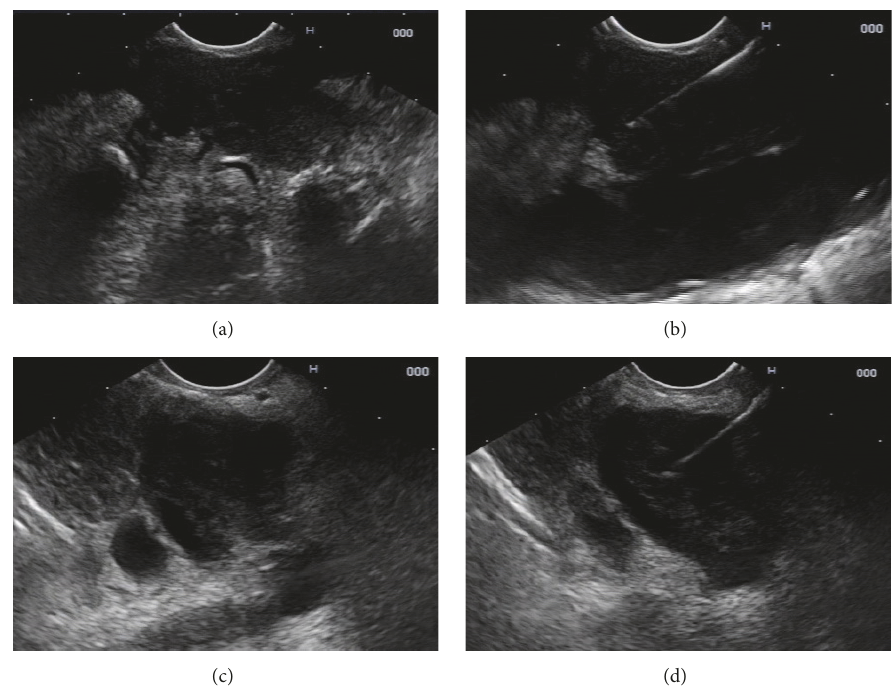
Figure 2: (a) Endoscopic ultrasound (EUS) demonstrating a 3 cm hypoechoic mass in the left lung. (b) EUS-guided fine needle biopsy (FNB) of the left lung nodule with a 25-gauge needle. (c) EUS demonstrating a 3.8 cm hypoechoic mass in the pancreatic body abutting the splenic artery. It shows the same internal echotexture as the lesion in the mediastinum. (d) EUS-FNB of the pancreatic mass with a 25-gauge needle.